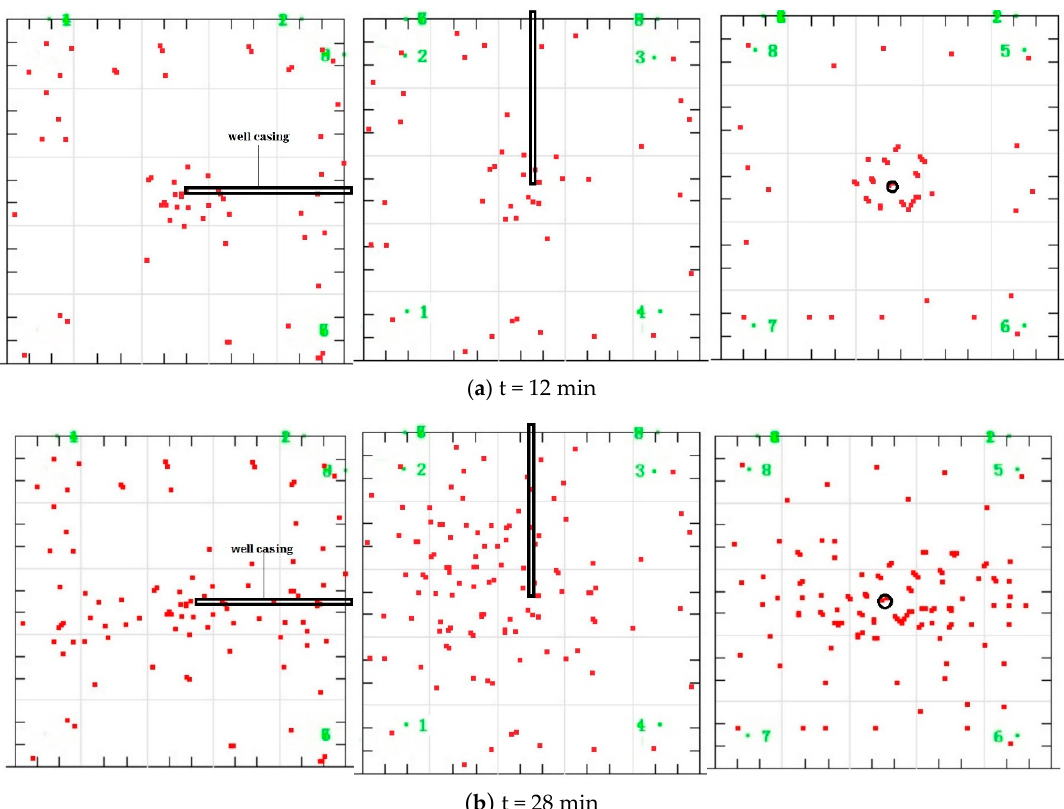
Figure 11. AE results of the fracturing of H1 at t = 12 min ( a ) and t = 28 min ( b ).